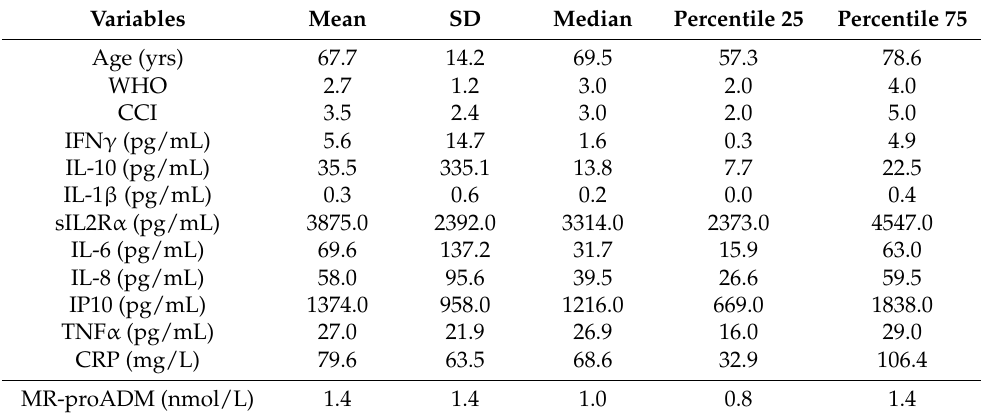
Table 1. Demographic, clinical and laboratory data of the study patients. SD = standard deviation; WHO score (World Health Organization; data were available in 372 patients); Charlson Co- morbidity Index (CCI); CRP: C-reactive protein; MR-proADM: mid-regional proadrenomedullin (normal range < 0.56 nmol/L). IFN γ normal range < 0.99 pg/mL; IL-10 normal range: 1.8–3.8 pg/mL;